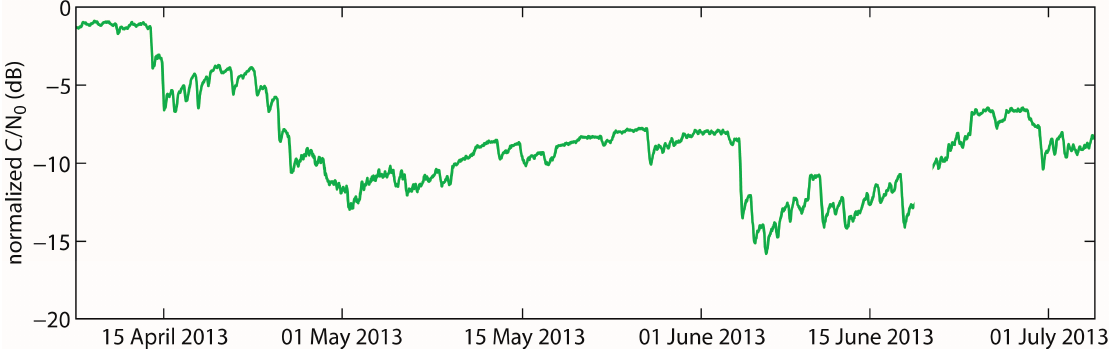
Figure 6. Normalized GPS C/N 0 values (dB) taken as the mean of the two GPS receivers under the snow cover (GPS2 and GPS3) at the Weissfluhjoch test site for the period 7 April–6 July